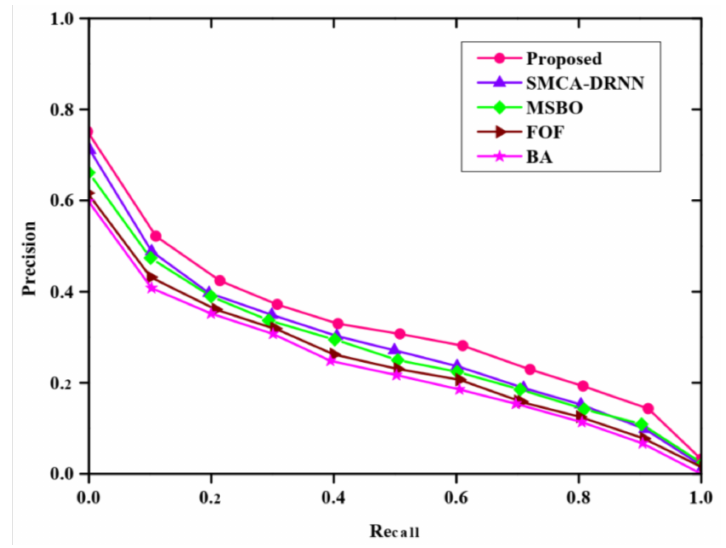
Figure 5. Comparative analysis of precision and recall without query expansion.